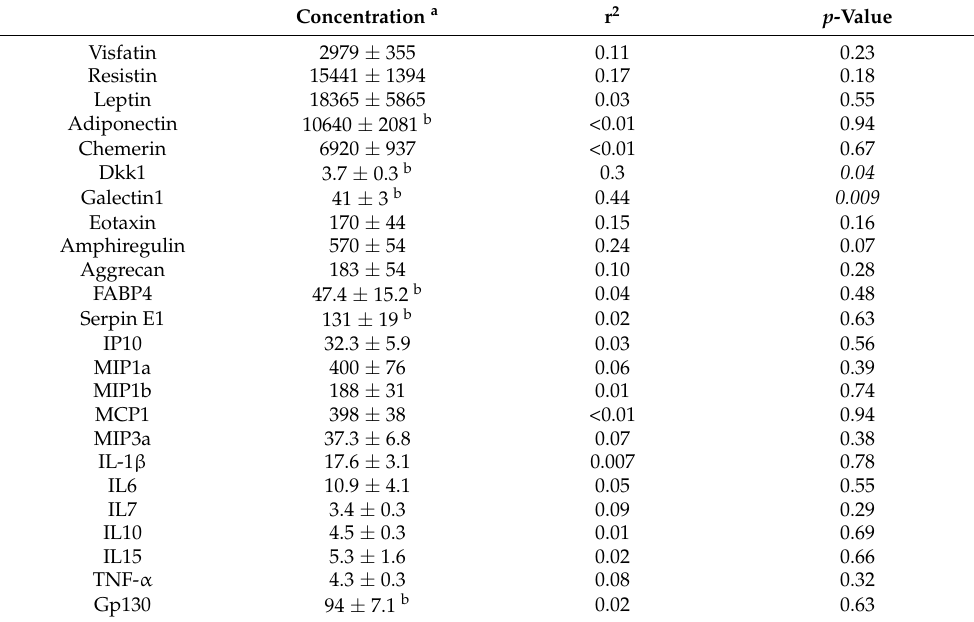
Table 2. Relationship between MALAT1 subchondral bone expression and the concentration of cytokines in OA patient